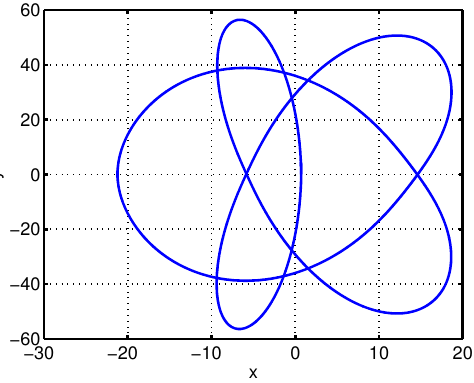
Fig. 2 Periodic orbit located at x = 0 . 7124, T = 173 for C = 1 . 1, and µ = 0 . 1